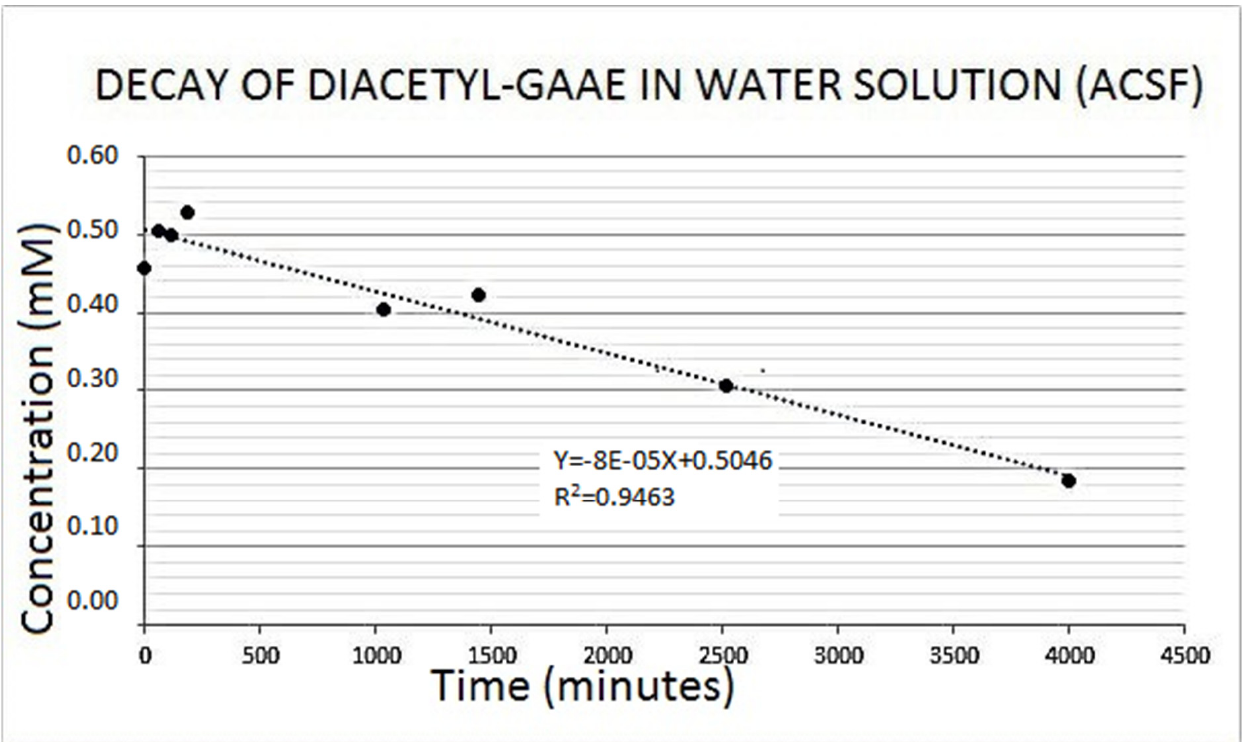
Figure 8. When dissolved in the aqueous artificial cerebrospinal fluid (ACSF) we used for brain slices’ incubation, Diacetyl-GAAE decayed linearly over time. Such a spontaneous decay was however very slow, and it did not occur in the period of our experiments. The latter lasted 3–4 h at most, a time when Diacetyl-GAAE concentration did not change. See text for additional details.